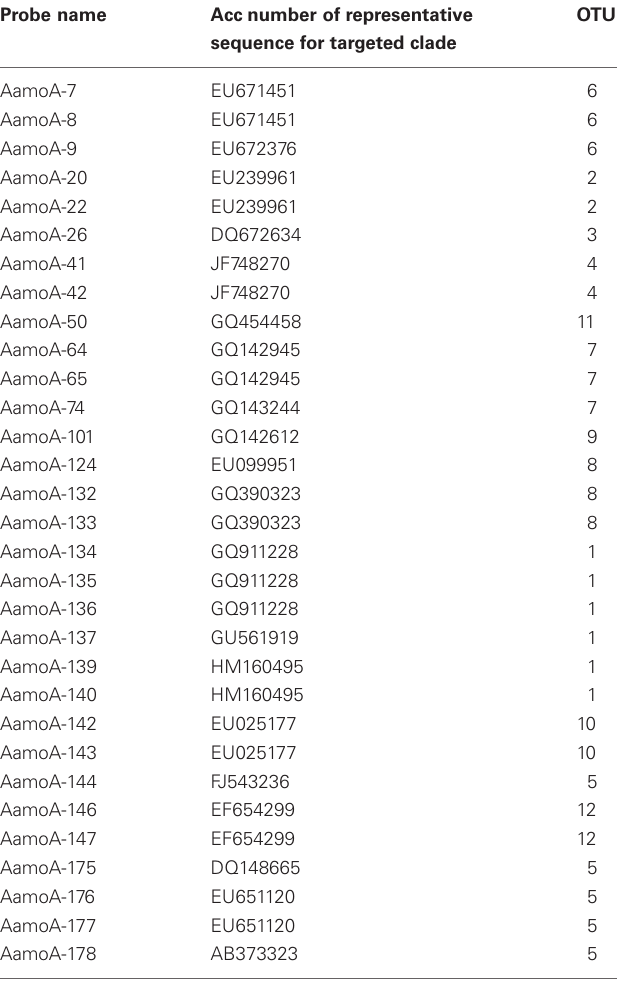
Probes with identical representative sequences target the same phylogentic clade and were treated as redundant